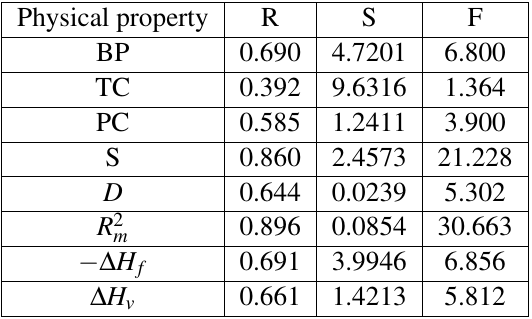
Table 9 Statistical parameters for the QSPR model (5).